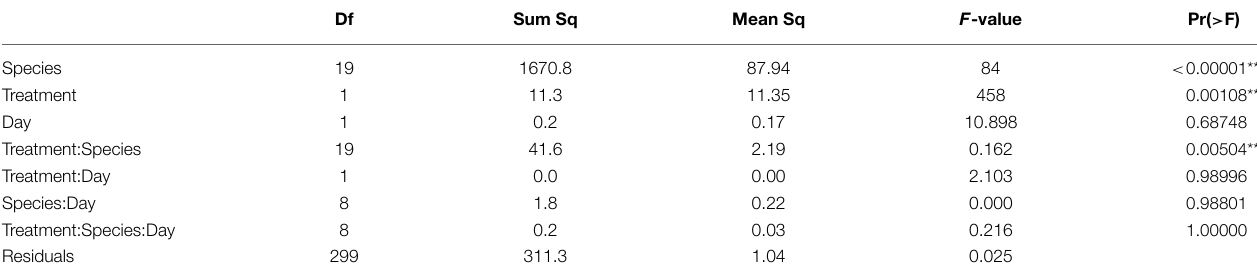
TABLE 3 | Results of the Three-Way ANOVA describing the effects of species, treatment and day on the respiration rate. Df Sum Sq